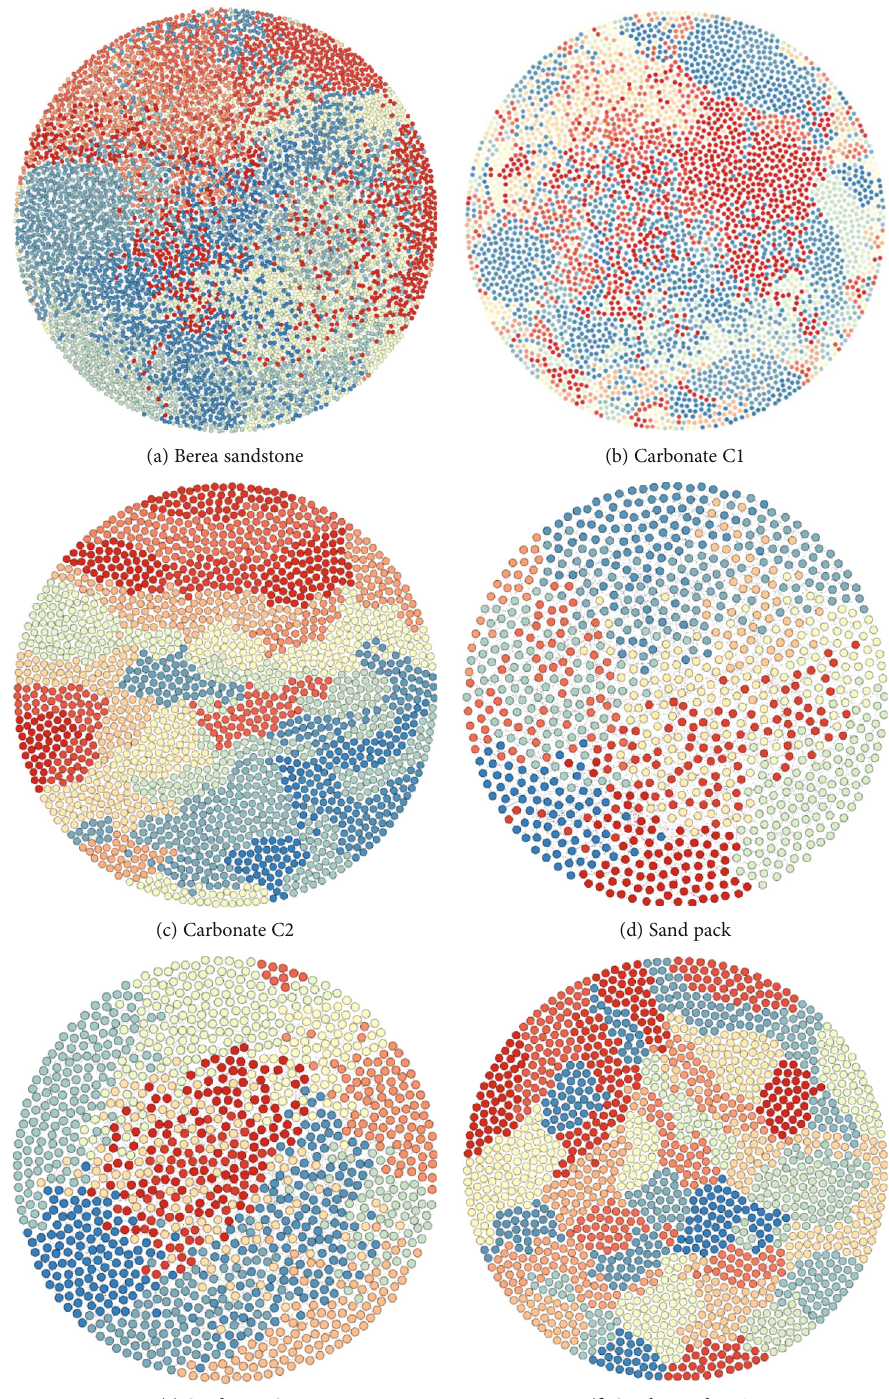
Figure 7: Modularity structure of rock pore